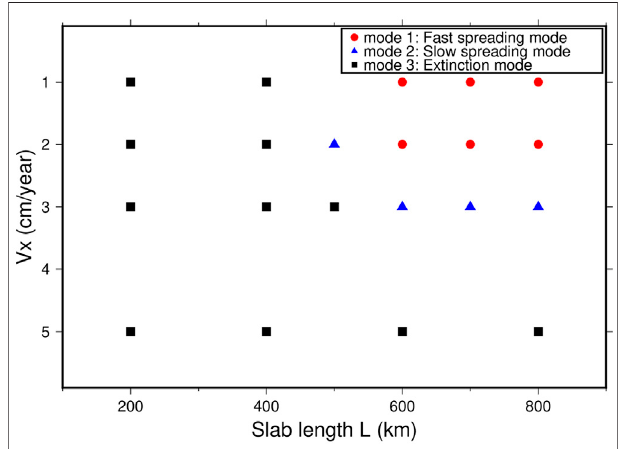
FIGURE 8 | In fl uences of the slab length L and the imposed velocity V x on the modes of trench-parallel MOR subduction. All of these cases have a ViscT&D mantle viscosity structure and an initial slab dip angle of θ (cid:1) 45 ° .